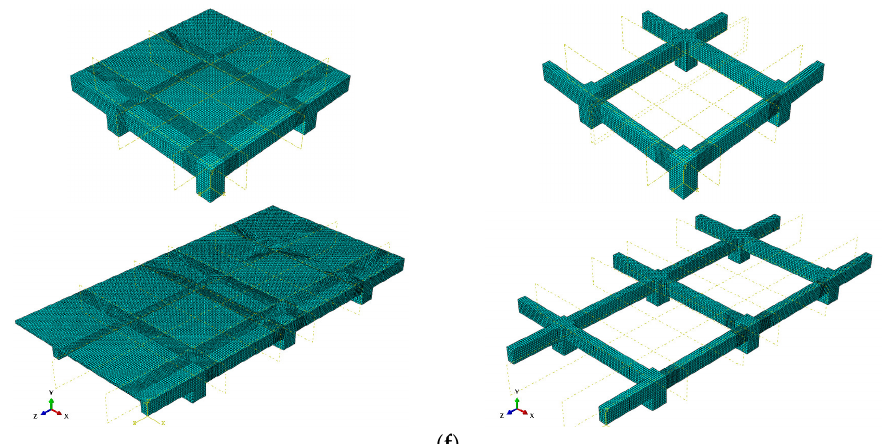
Figure 17. Assignment of loading and boundary conditions of all specimens: ( a ) NC-COR and RuC-COR; ( b ) NC-COR-Slab and RuC-COR-Slab; ( c ) NC-MID and RuC-MID; ( d ) NC-MID-Slab and RuC-MID-Slab, ( e ) applying of downward displacement; and ( f ) meshing of specimens. Table 9. Details of the FE analysis matrix for the 3D beam–slab substructures.